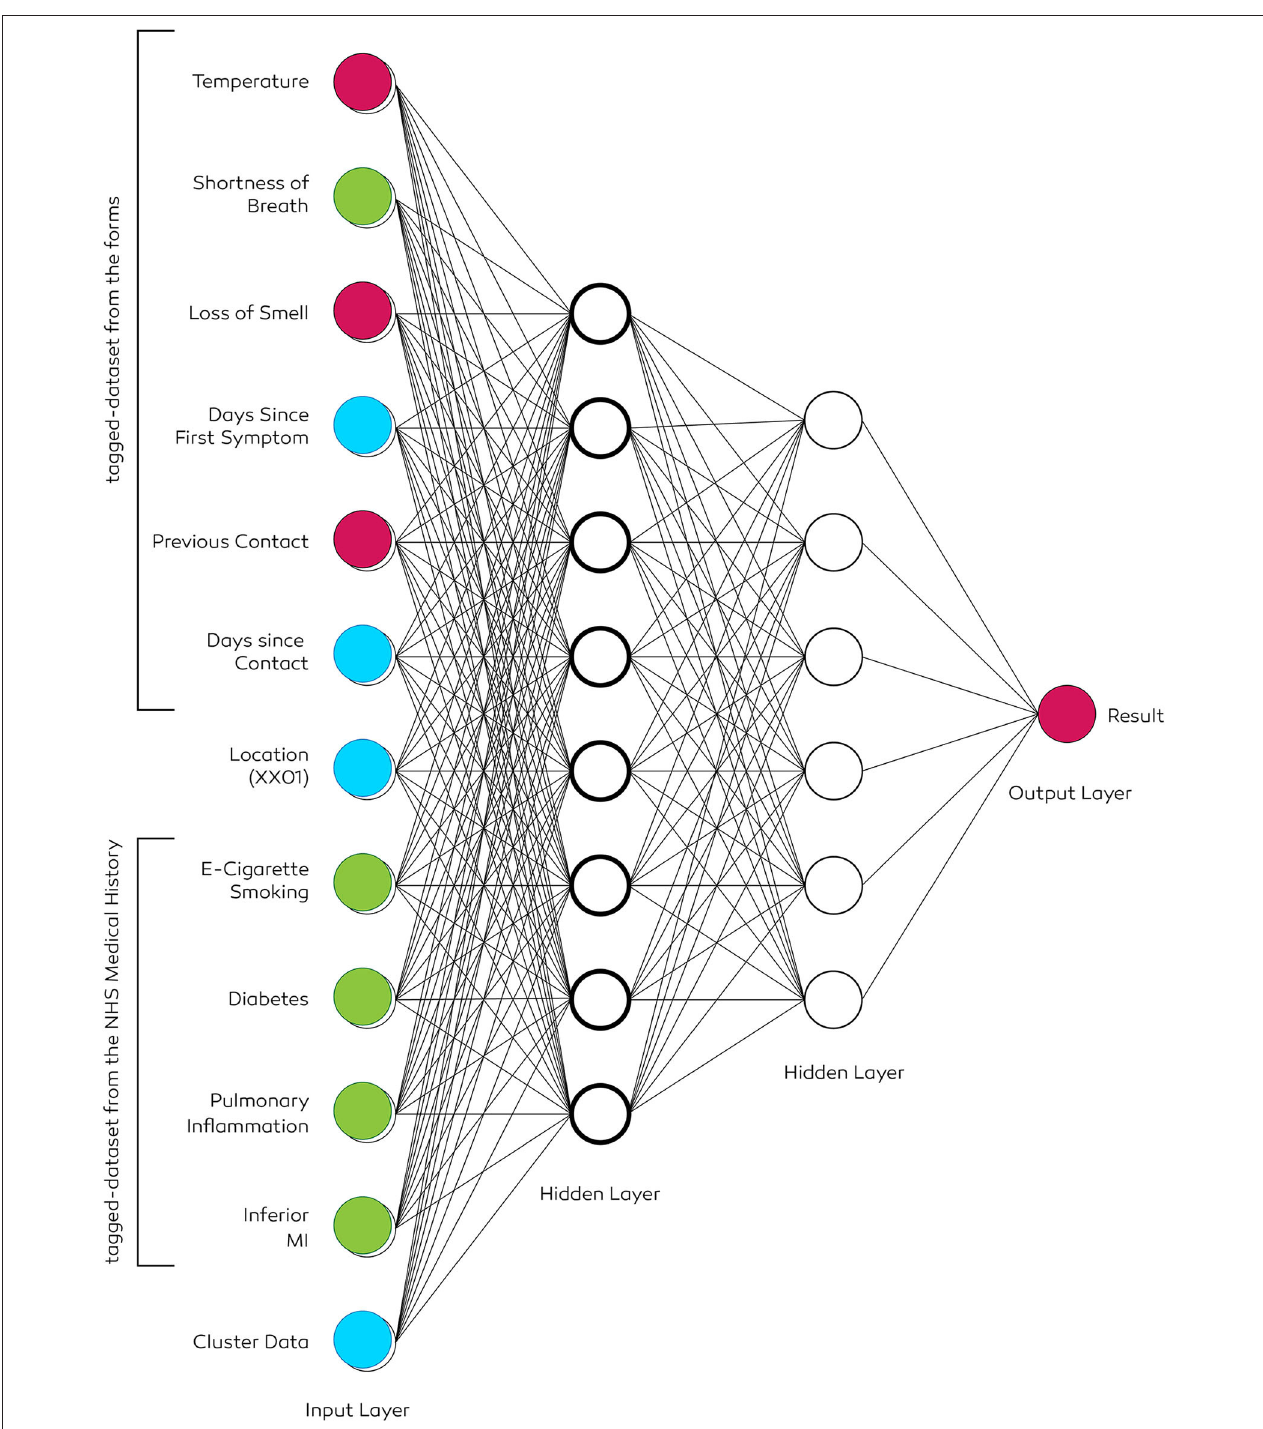
FIGURE 13 | The architecture of a two-level deep neural network. Input data of the patient includes a history of smoking, diabetes, inferior MI, and pulmonary inflammation. Tuning hyperparameters ensures selecting the necessary set of parameters to deduce a result. The location data is obtained if the user permits via the “permission settings.” It allows generating geo-heatmaps based on the first three or four digits (e.g., NW1 or EC20) of the postcode.